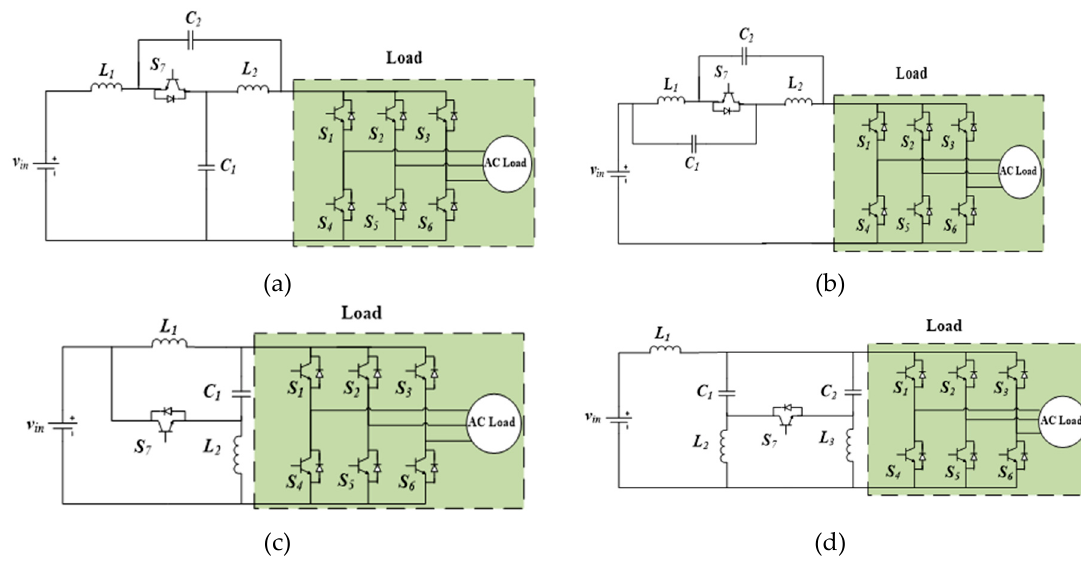
Figure 2 . Bidirectional quasi-Z-source inverter topologies: voltage-fed one with continuous current ( a ); voltage-fed one with discontinuous current ( b ); current-fed one with continuous current ( c ); current-fed one with discontinuous current ( d ).